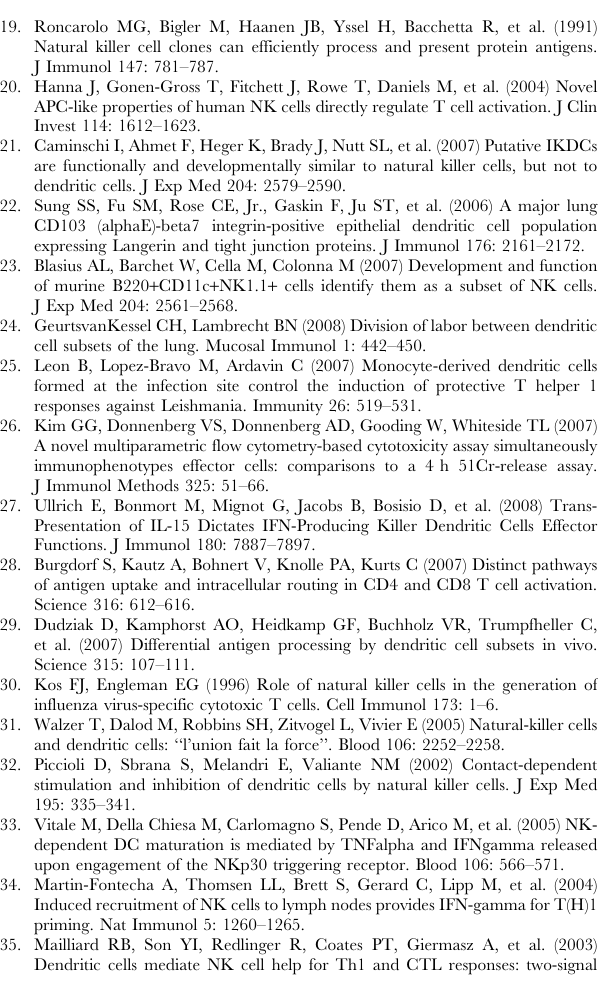
Figure S1 Effect of NK1.1 depletion of APC capacities of lung cDCs. (A) Expression of CD86 on cDCs taken at 4dpi from the lungs of influenza infected mice, that were treated with depleting NK1.1 antibody or isotype control. (B) Antigen presenting capacity of cDCs sorted from lung tissue at 4 days after infection with WSN containing an OVA-CD8 + epitope. Sorted cells were co-cultured for 4 days with CFSE-labelled OVA specific CD8 T cells (OT1). A comparison was made between cDCs sorted from NK depleted mice (NK1.1-) versus non-depleted mice, which received an isotype control injection (PBS). Numbers in top left corners represent the percentage of cells recruited into cell division. Found at: doi:10.1371/journal.pone.0007187.s001 (4.77 MB TIF) Figure S2 Depletion of NK1.1 + cells during in vivo influenza virus infection affects infection parameters at various time points following infection. Mice were treated with depleting NK1.1 antibody or isotype control during influenza virus infection. (A) Viral titers were measured in lung tissue at day 5, 7, and 13 post infection. (B) Left plot shows TM specific CD8 + T cells measured in MLN at day 5, 7, and 13 pos infection. Right plot demonstrates IFN c producing CD8 + T cells in MLN, measured by intra-cellular staining. (C) % of CD4 T cells in MLN following infection. (D) Hemagluttinin specific antibodies in serum were measured at 8 dpi